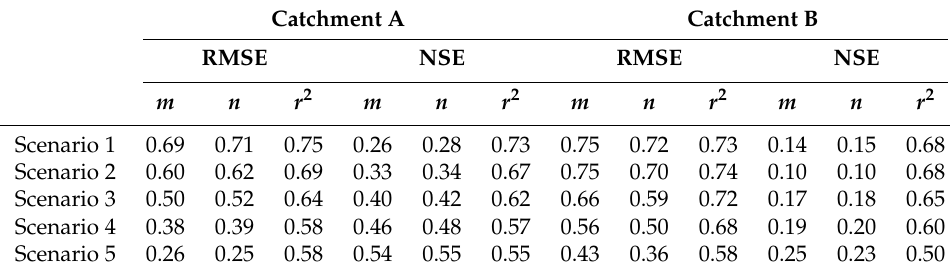
Table 3. Parameters m and n and corresponding coefficient of determination ( r 2 ) of Equation (7) for the two analyzed catchments and both skill scores. Results refer to the GERM model. Catchment A Catchment B RMSE NSE RMSE